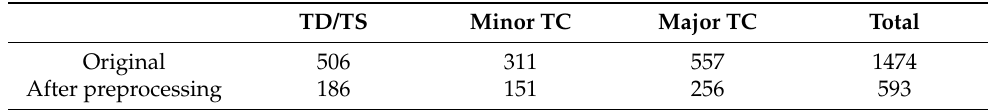
Table 1. Number of TC cases in original dataset and after preprocessing. Preprocessing includes spatial restriction and temporal filter.